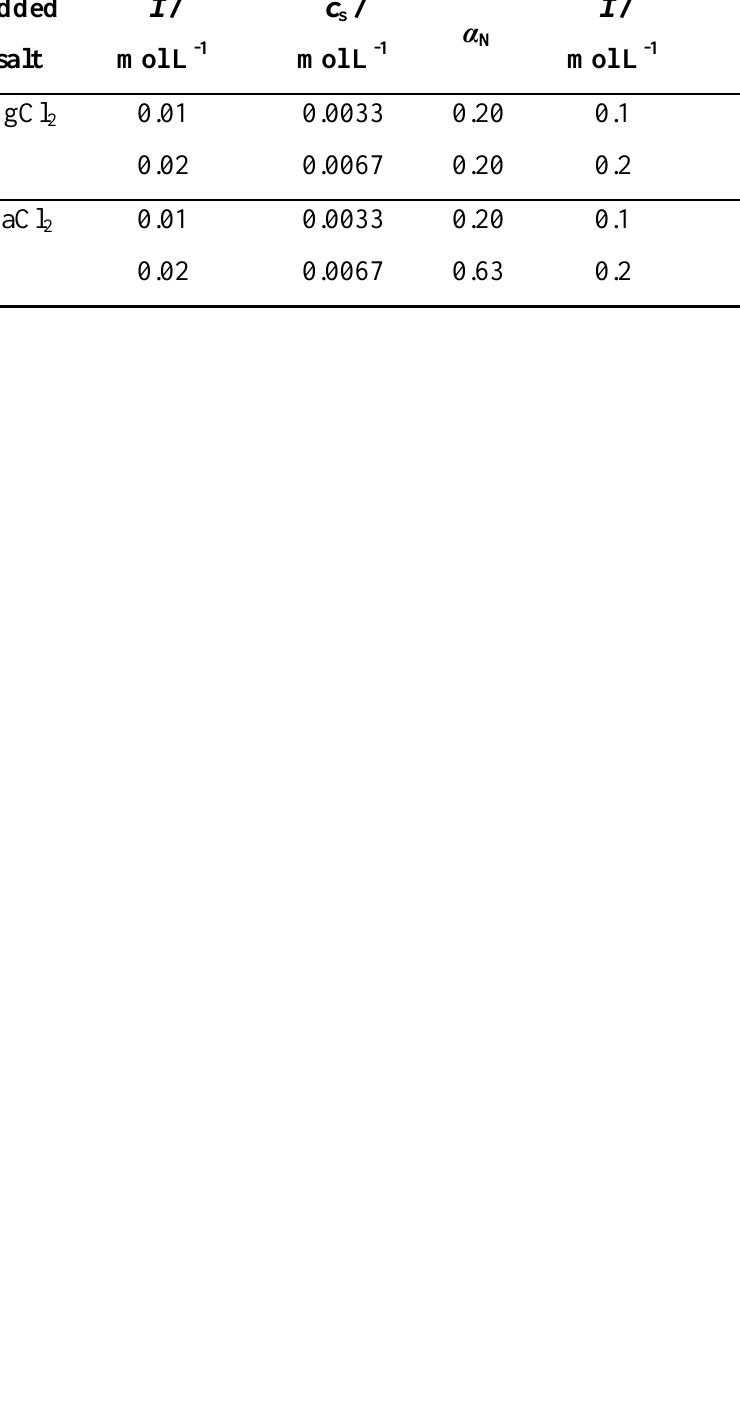
and CaCl ) and the final ionic strengths ( I ) (all at 2 2 is given in the Table) and aPMA ( c = 0.023 mol L -1 , α N p